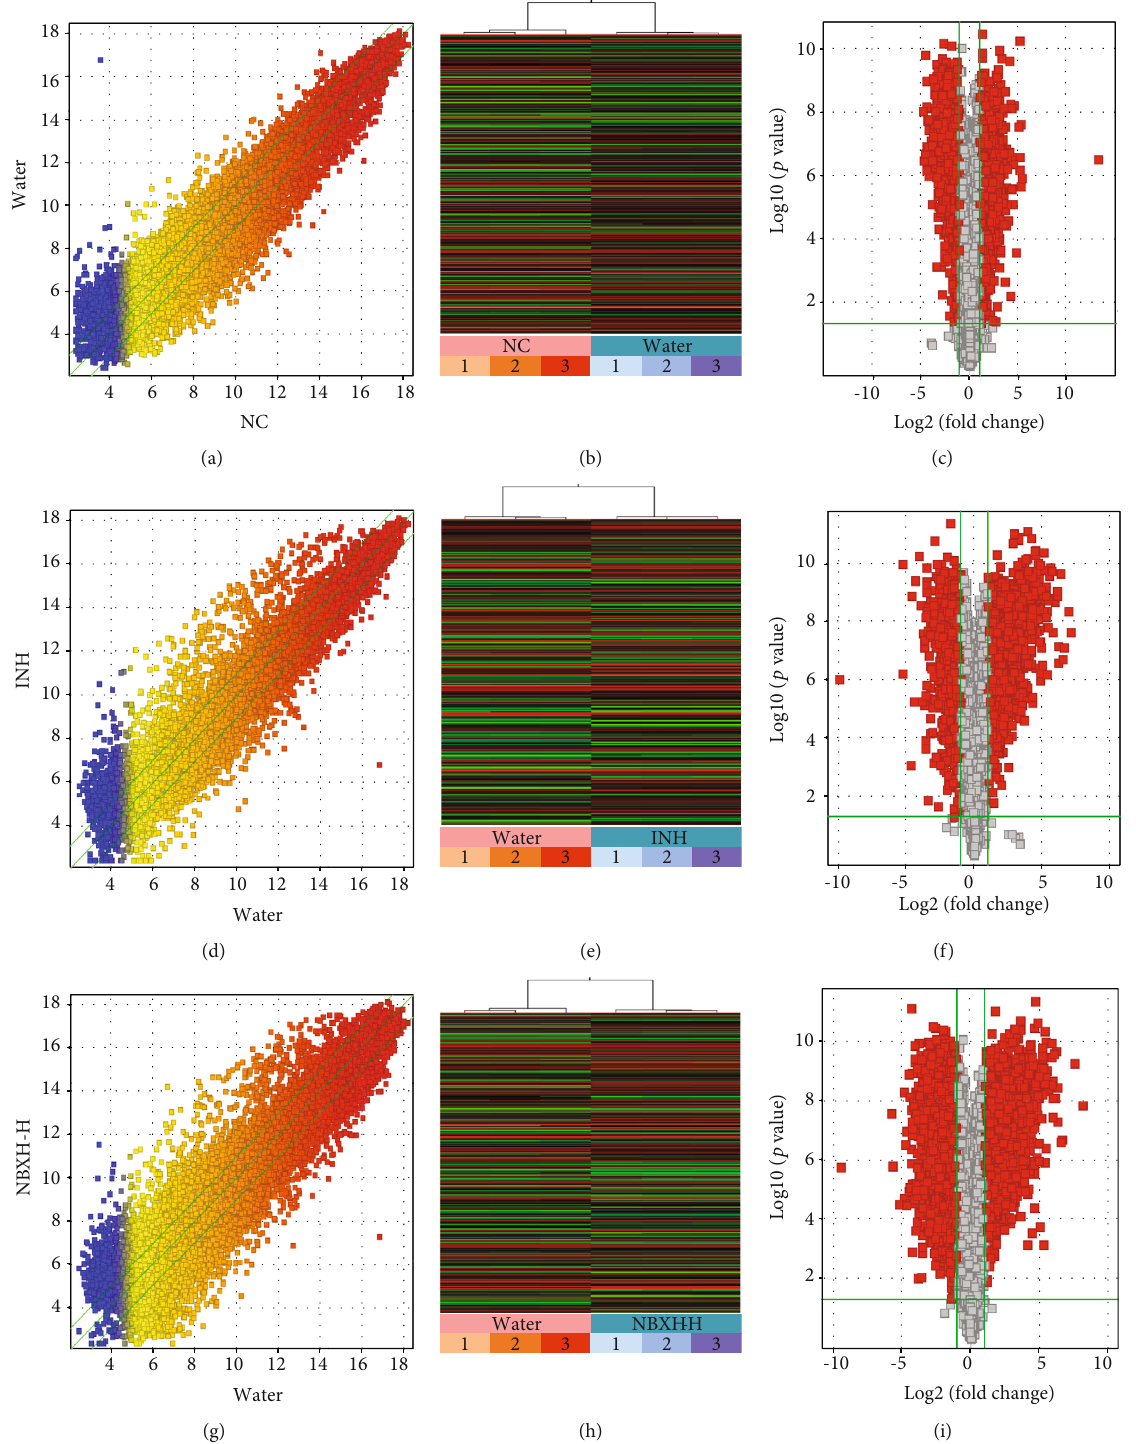
Figure 4: Scatter plot, hierarchical clustering, and volcano plot of the expression pro fi le of genes between Water and control, or INH as well as NBXH-H treated groups. (a, d, and g) Scatter plots; the values of x and y axes in the scatter plots are the normalized signal values of the samples (log2 scaled) or the averaged normalized signal values of the groups (log2 scaled). The green lines are fold change lines (the default fold change value given is 2.0). The genes above the top green line and below the green bottom line indicated more than a 2-fold change of genes between two samples or groups ( n = 3 ). (b, e, and h) Hierarchical clustering shows the relationships among gene expression patterns of samples ( n = 3 ). Red indicates high relative expression, and green indicates low relative expression. (c, f, and i) DE genes with statistical signi fi cance were identi fi ed through the volcano plot, and the red diamonds represent DE genes with foldchange ≥ 2 : 0 , P ≤ 0 : 05 ( n = 3